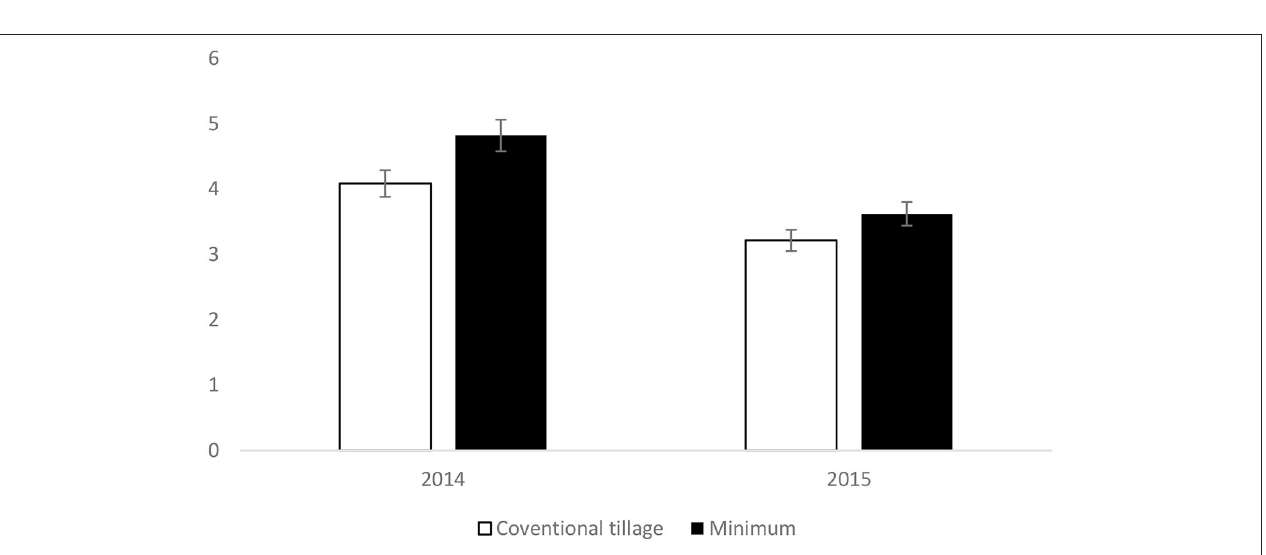
FIGURE 3 | Cumulative CH 4 emissions in spring wheat as affected by conventional tillage (hollow bars) and minimum tillage (filled bars). Data re-plotted from Yeboah et al.